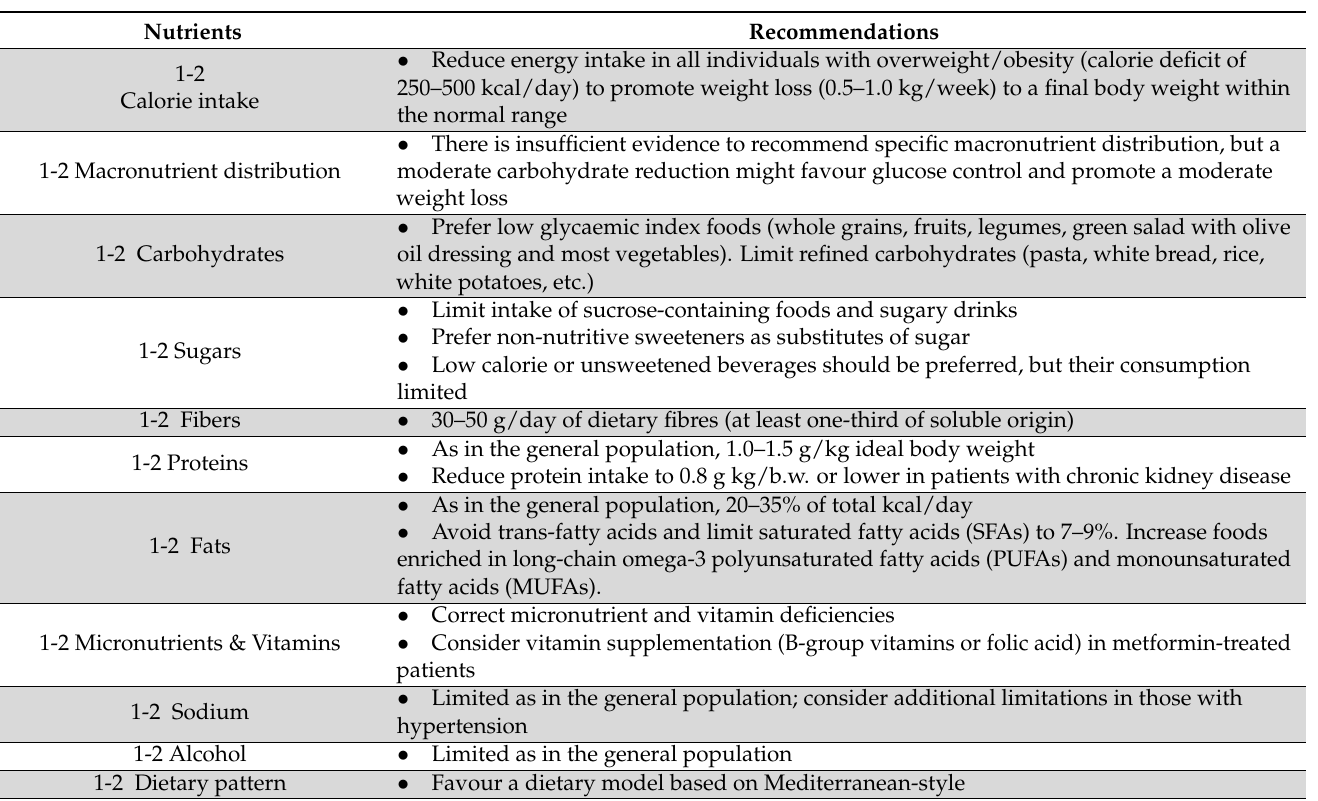
Table 2. Summary of nutritional recommendations for type 2 diabetes, as derived from international guidelines. Nutrients